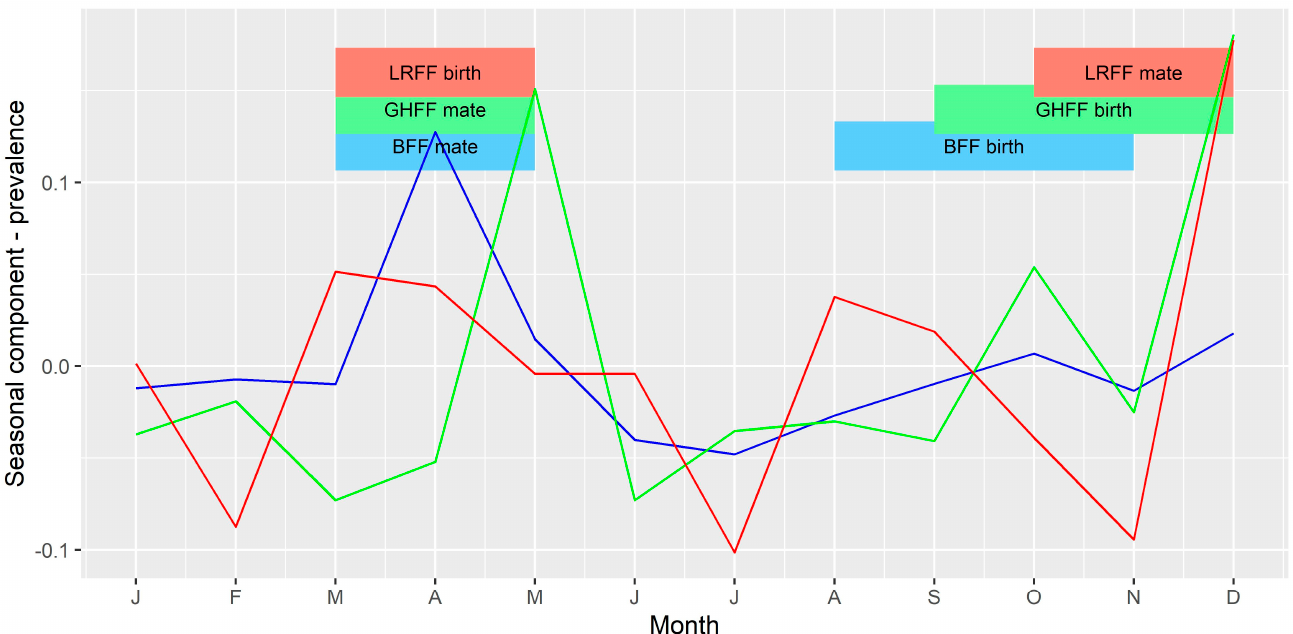
Figure 8. Seasonal component of time series of ABLV prevalence per month. The vertical axis represents the expected increase or decrease in prevalence (as a proportion) in each month. Blue = BFF; green = GHFF; red = LRFF.